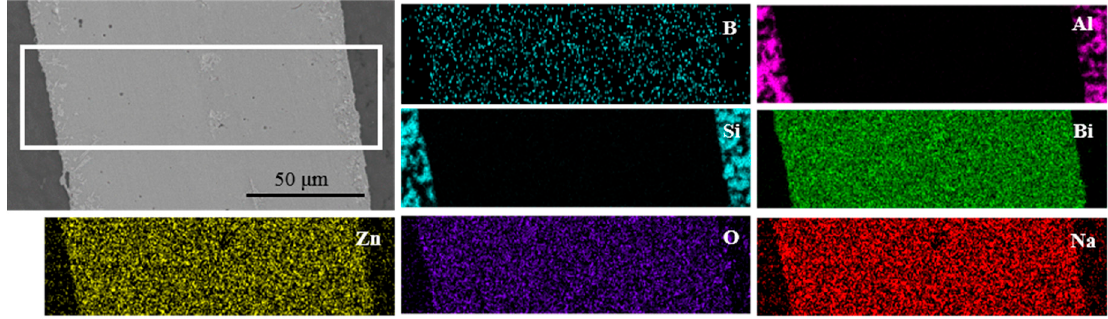
Figure 12. EDS maps of different elements in joint made at brazing temperature of 495 °C for 30 min.